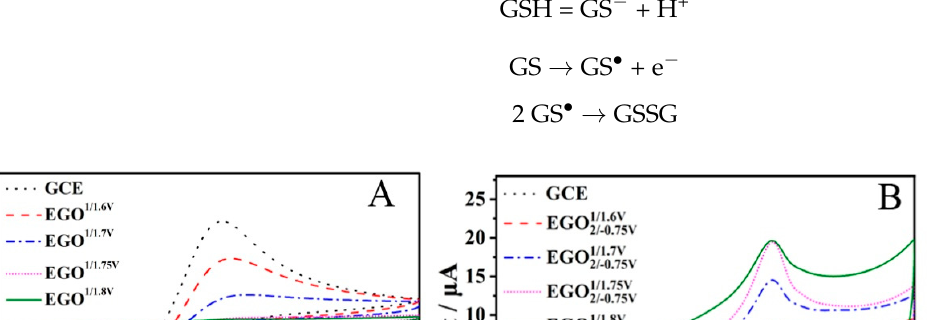
Figure 6. CVs of different EGO 1/potential and EGO 1/potential ( B ) in pH 5.0 PBS.